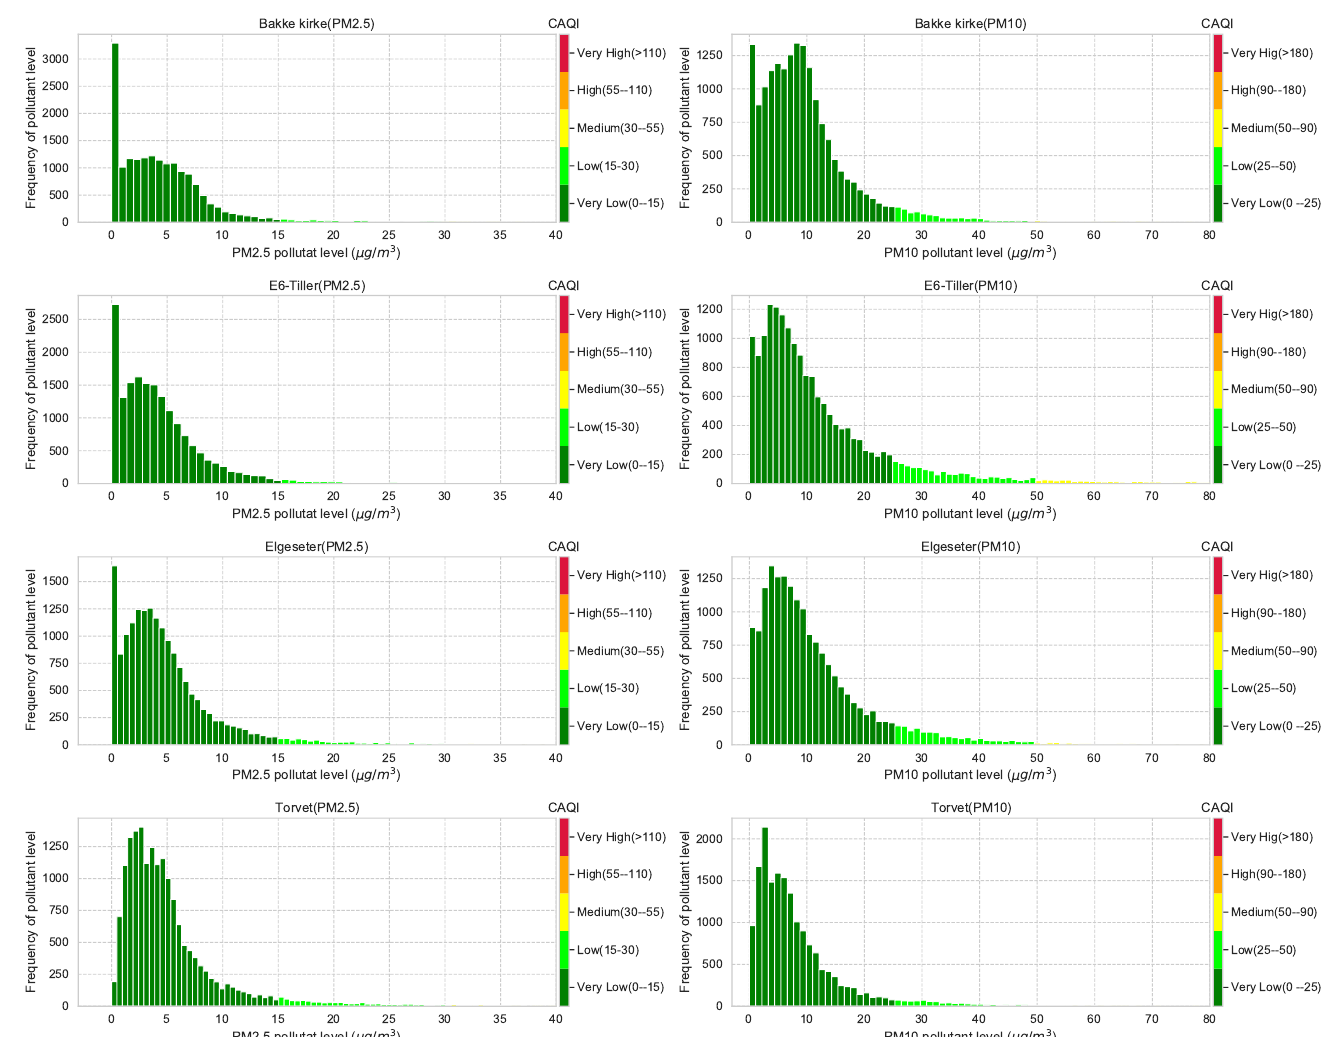
Figure A7. Histograms that approximately represent the distribution of air quality at four monitoring stations in the city of Trondheim. The air quality data come from heavily right-skewed distributions, in which higher CAQI classes are